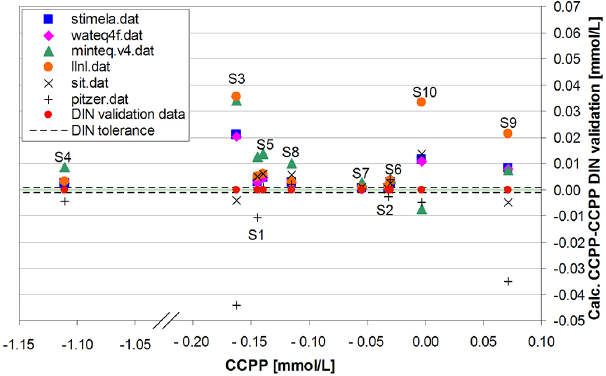
Figure 5. Deviations of the CCPPs calculated in PHREEQC with the widely used chemical databases, from the CCPPs given in the DIN validation data set for the 10 water quality samples S1 to S10 (see Table